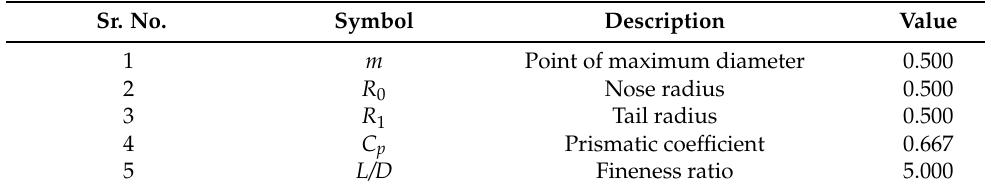
Table 1. Design parameter values for ellipsoid profile. Sr.